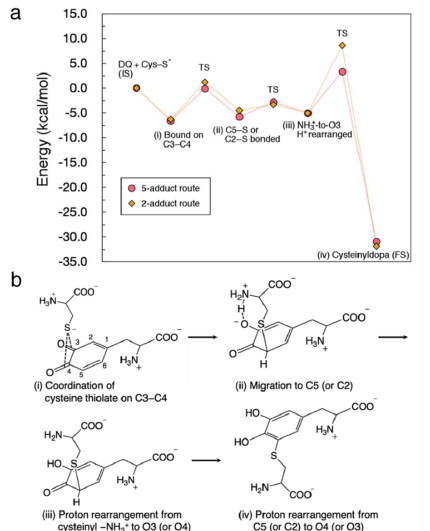
Figure 8. Overview of the reaction between Cys–S − and DQ. ( a ) Energy diagram for the formation of 5- S -cysteinyldopa and 2- S -cysteinyldopa plotted as circles and diamonds, respectively. ( b ) Proposed binding